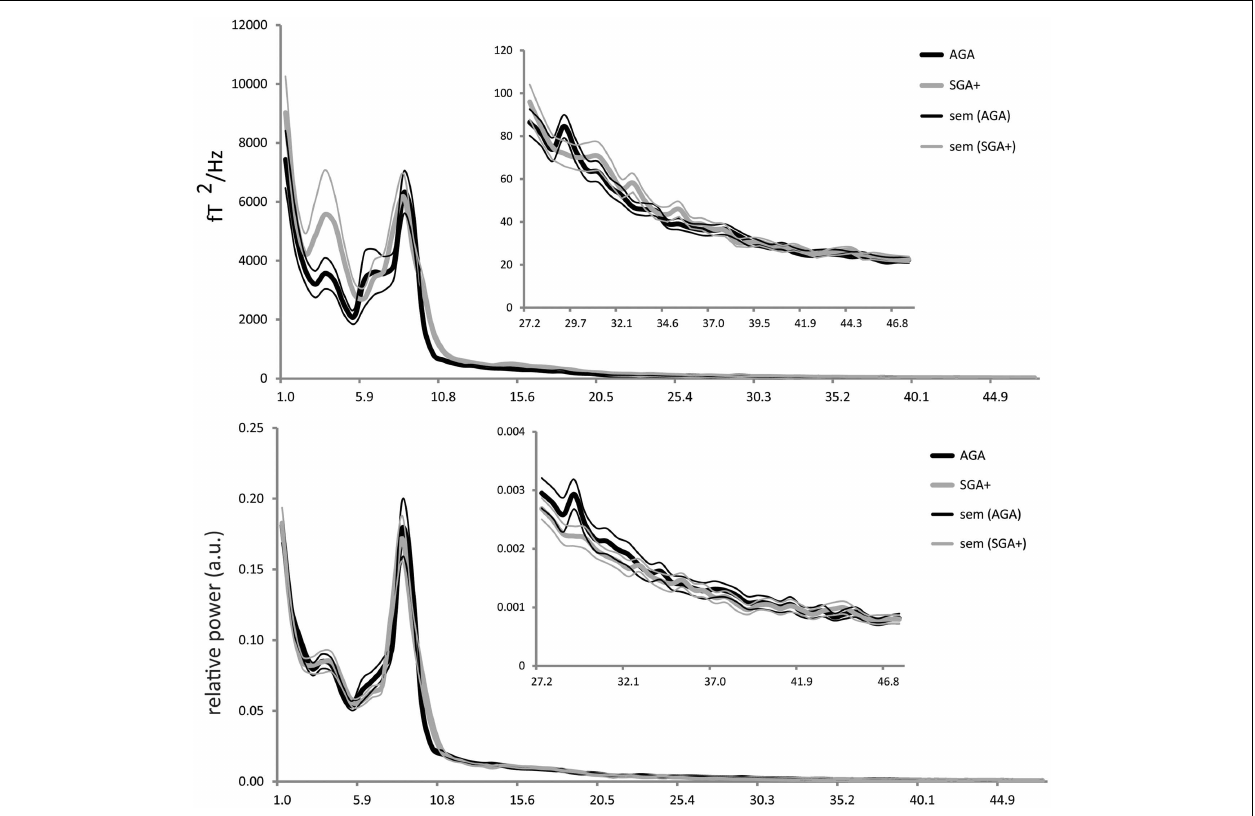
FIGURE 1 |Absolute power ( y -axis: absolute power in fT2/Hz; x -axis: frequency in Hertz) and relative power ( y -axis: arbitrary units; x -axis: frequency in Hertz) averaged for theAGA and SGA born groups, per group averaged over all MEG sensors (five epochs per child) .Thick solid black lines represent the average of AGA born children; thick gray lines the SGA + born children (standard errors of the mean are represented in thin